Question: What direction does the quantity move in — increasing or decreasing?
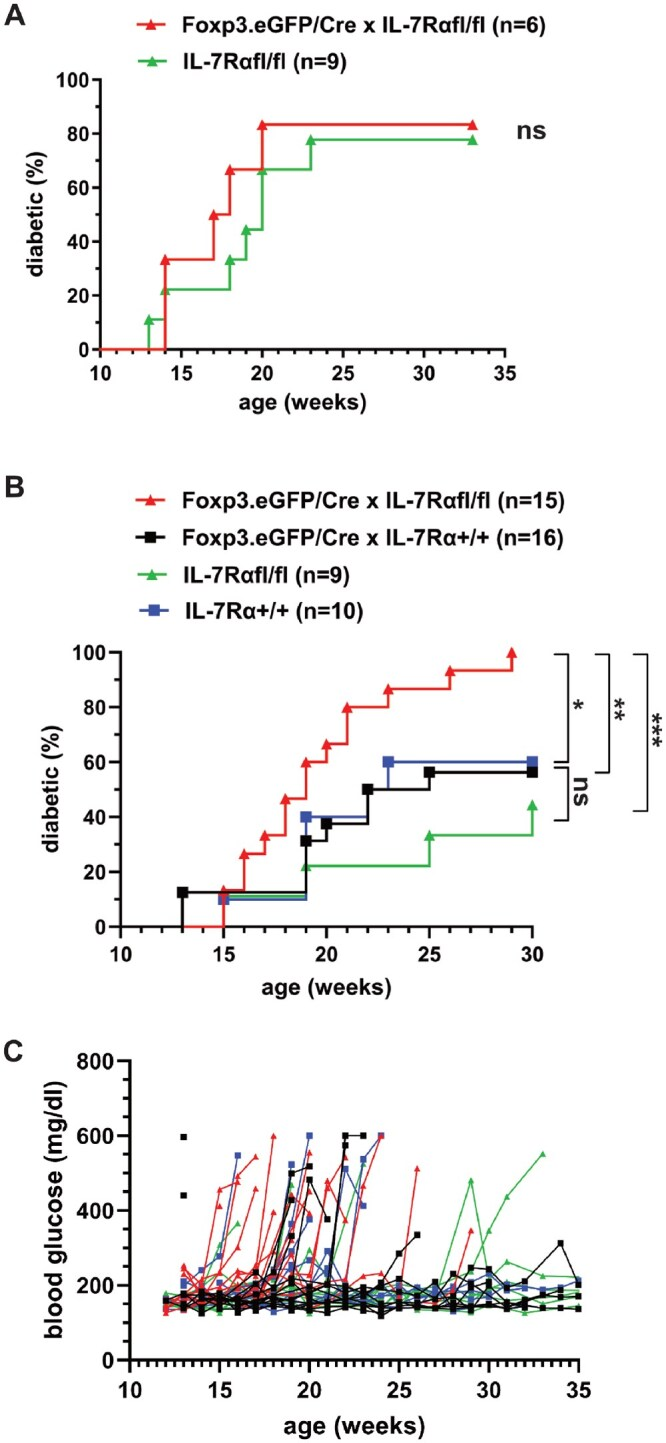
Answer: increasing